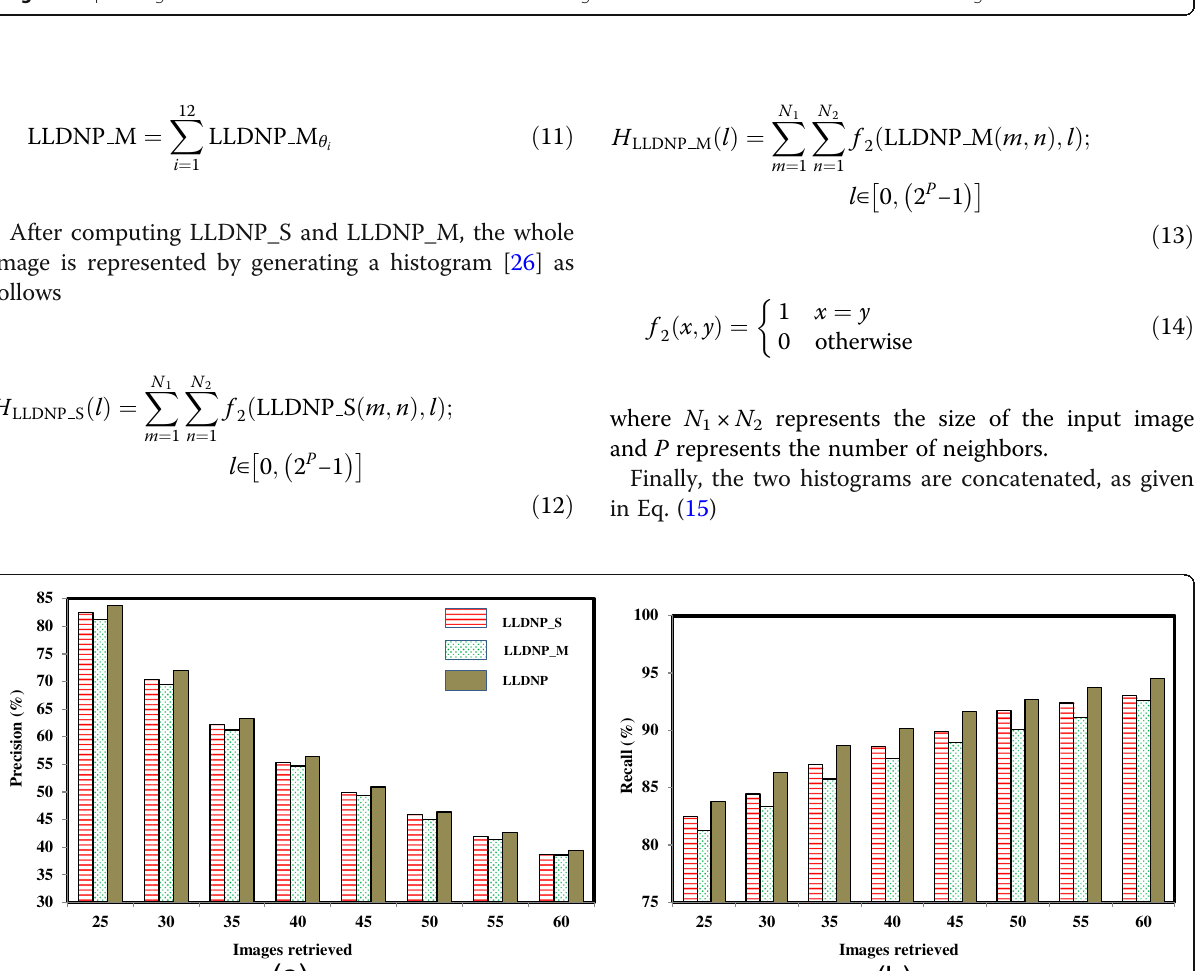
Fig. 4 Sample images from Brodatz database. One hundred twelve images from Brodatz database are shown in the